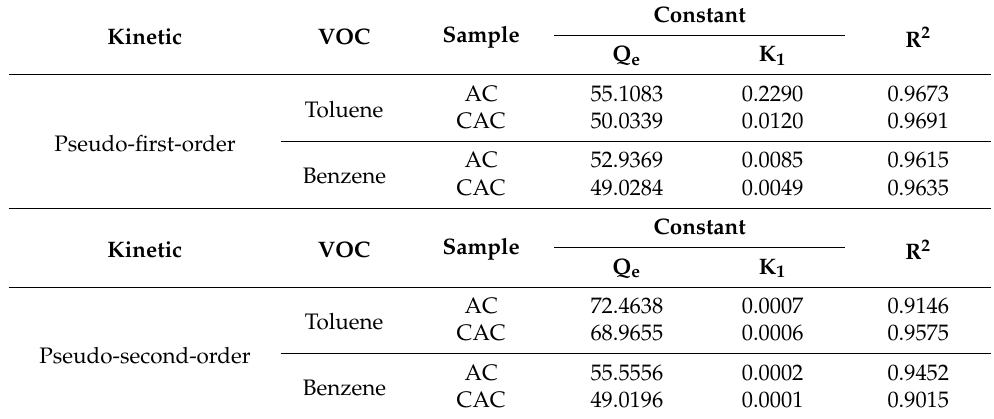
Table 5. Pseudo-first-order and pseudo-second-order kinetic parameters of samples. Kinetic